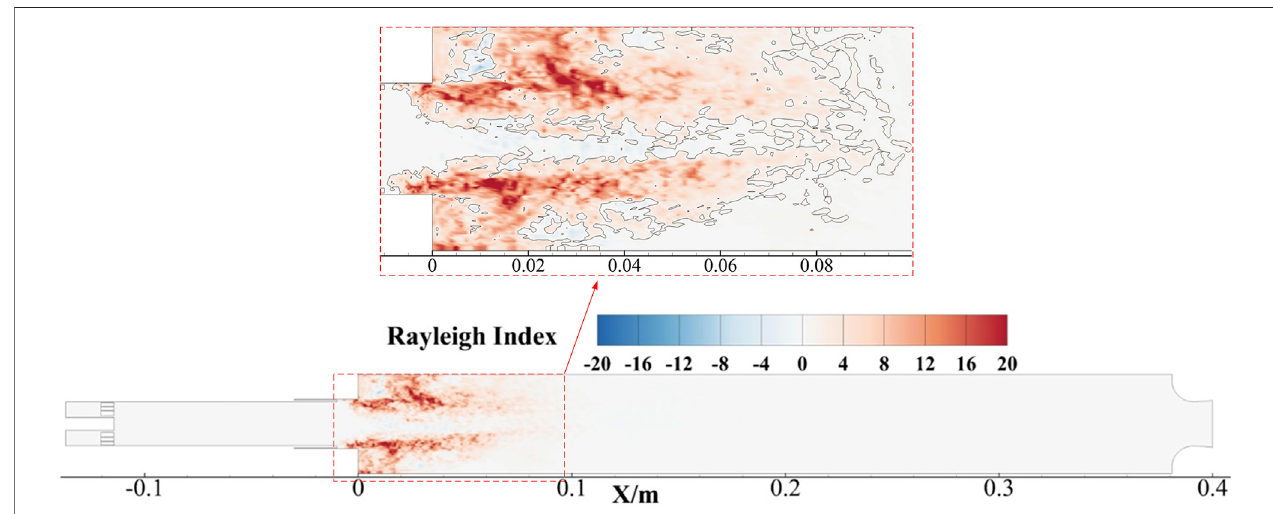
FIGURE 14 | Rayleigh index of the center plane (YZ). A close-up view near the combustor step with zero contours is on the top of the